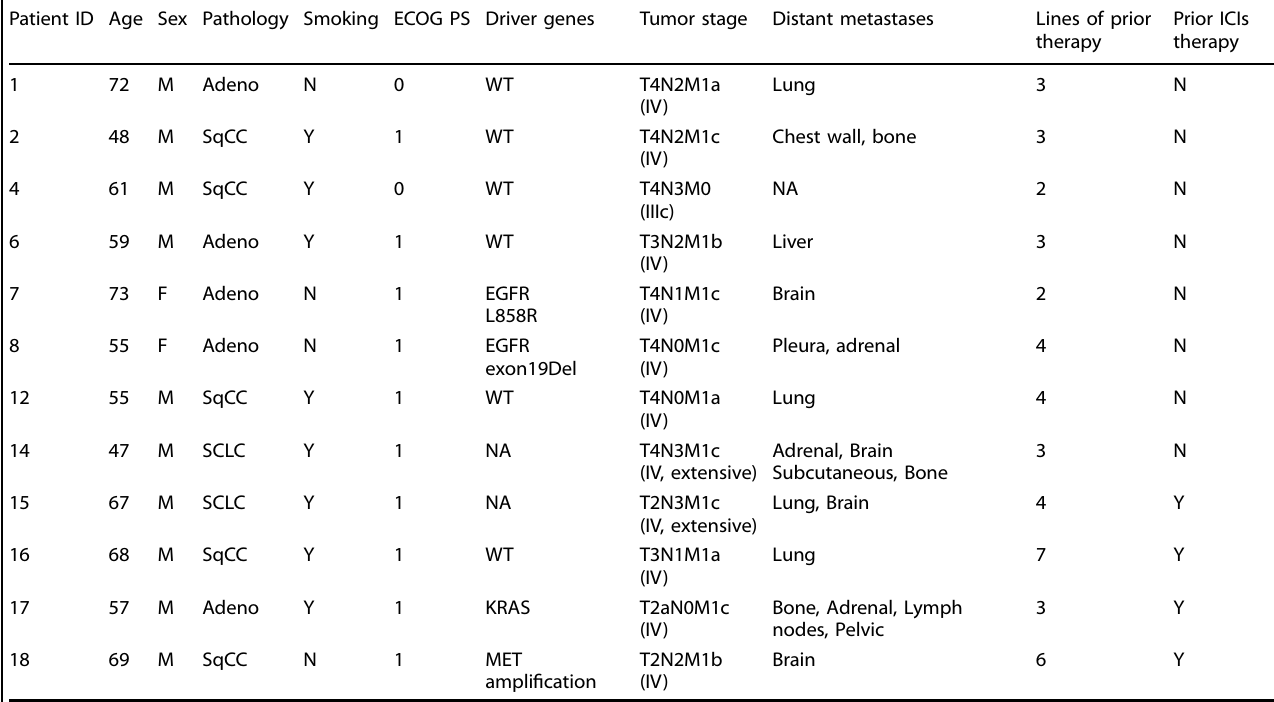
Table 1. Baseline clinical characteristics of